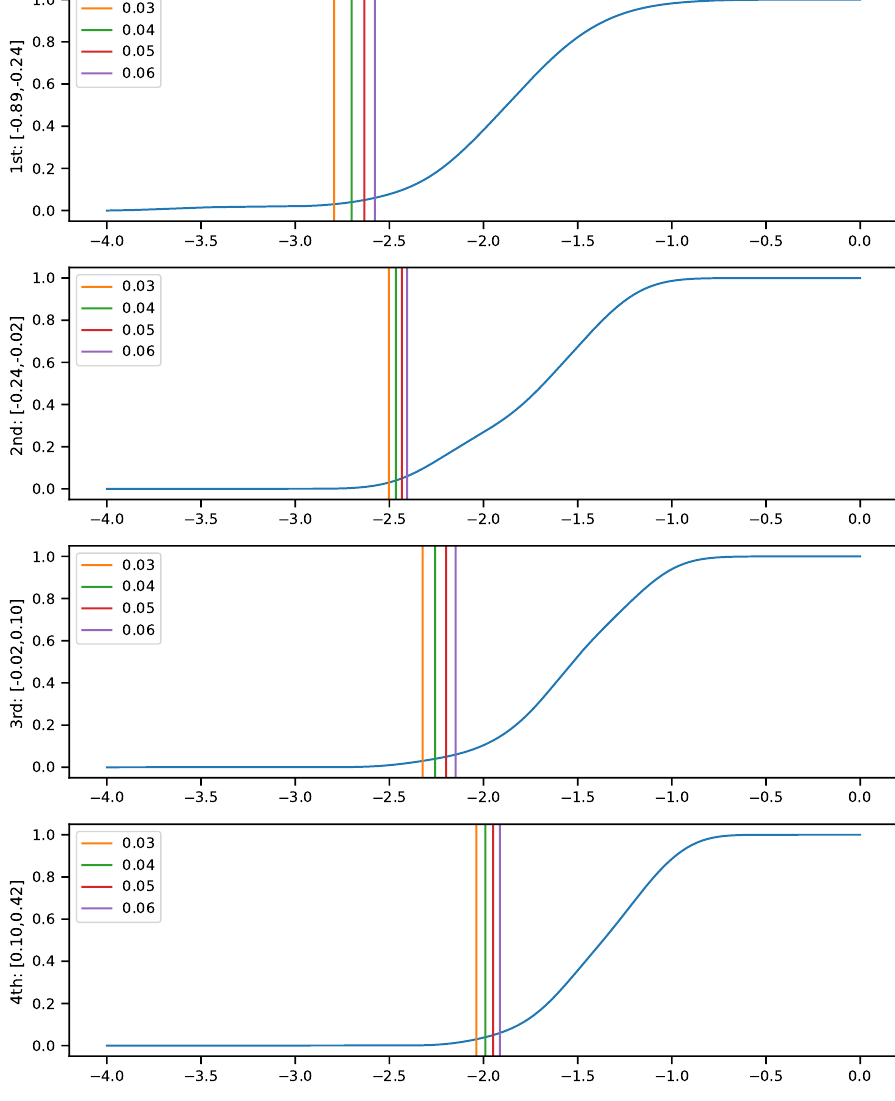
Figure 7. The cumulative distribution function of planetary masses over a succession of metallicity bins from the bottom to the top, with each bin containing 53 data points, except for the last bin, which has 54 data points. The ranges of the bins are shown on the left y-label. The vertical lines mark the “minimum mass” of the bin as set at the 3%, 4%, 5%, or 6% limit of this cumulative distribution, as shown in the